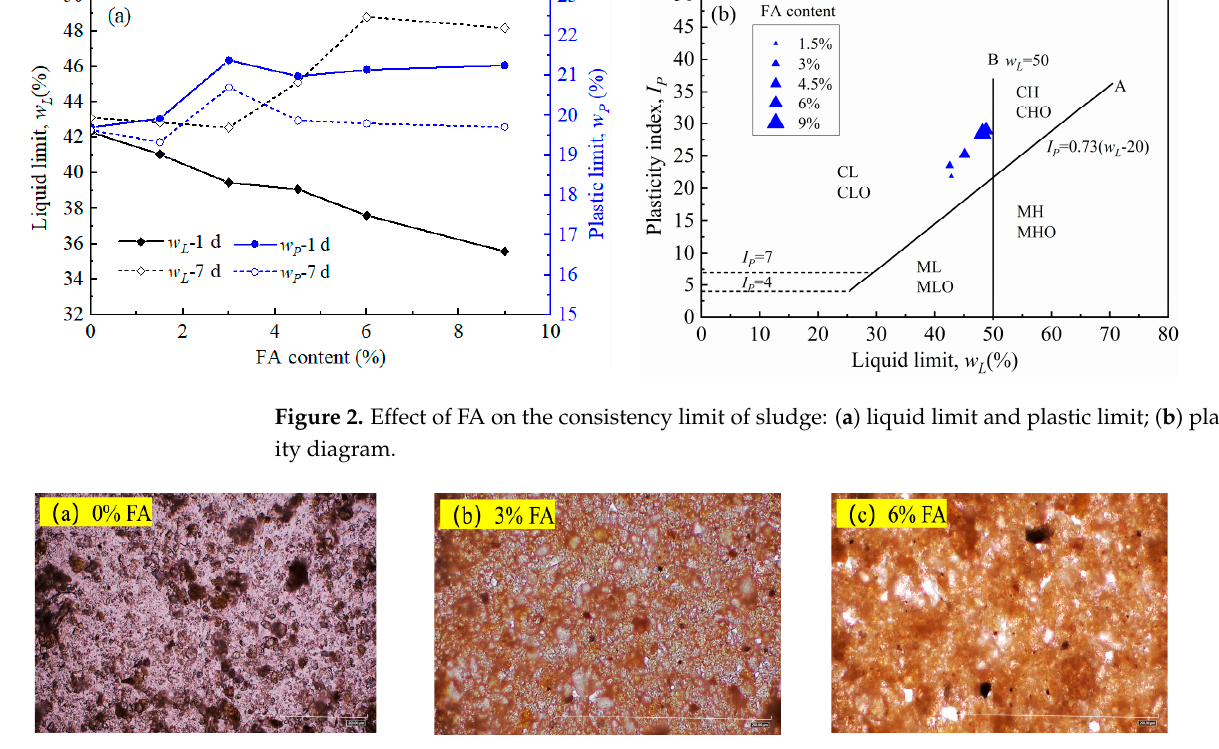
Figure 3. Microscopic morphology: ( a ) sludge with 0% FA, ( b ) sludge with 3% FA, and ( c ) sludge with 6% FA.